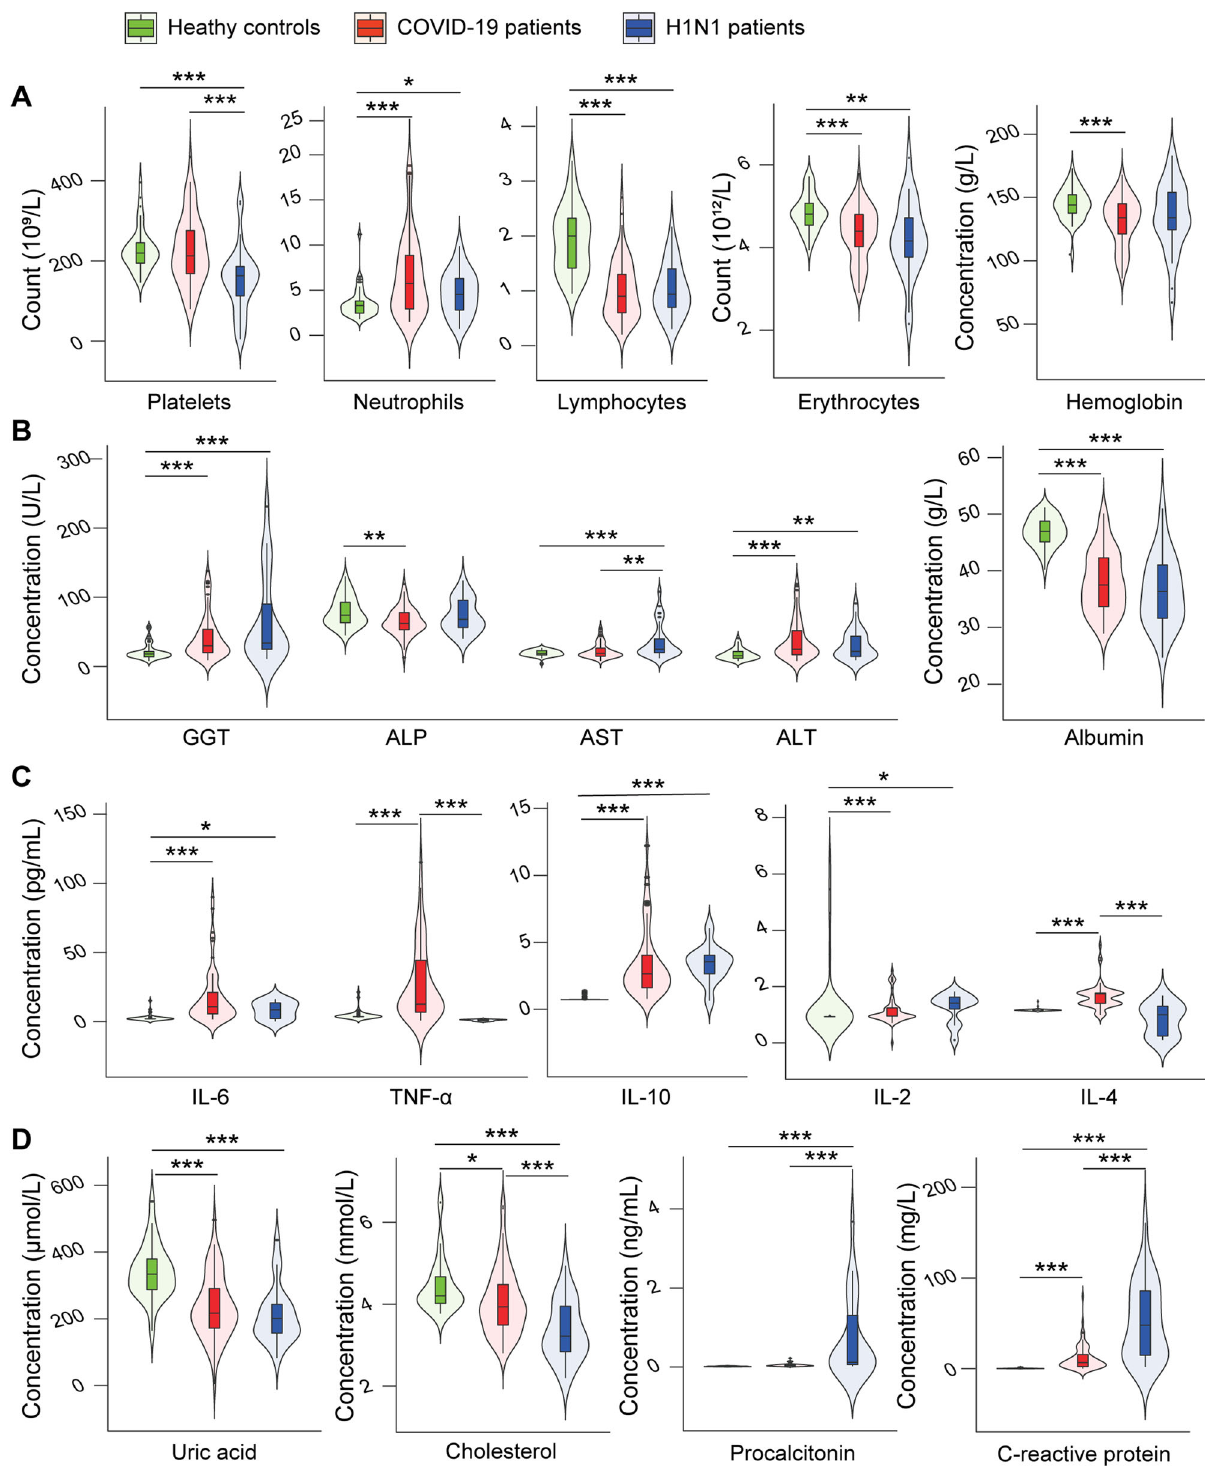
Fig. 1 Alterations in in fl ammatory, hepatic, metabolic and infectious biomarkers in blood from patients with COVID-19 or H1N1 infections compared with HCs. Signi fi cantly altered ( A ) blood haemocytes and haemoglobin, B liver function indicators, C in fl ammatory cytokines, and ( D ) metabolic and infectious biomarkers in the blood of patients with COVID-19 ( n = 67) or H1N1 ( n = 35) infections compared with HCs ( n = 48). * P < 0.05; ** P < 0.01; and *** P < Associations between faecal mycobiota and the bacterial Agathobacter , Dorea and Roseburia ; with Ruminococcaceae and microbiota . In COVID-19 patients, the phylum Ascomycota its genera Butyricicoccus and Faecalibacterium ; and with Egger- thella and Veillonella (Fig. 5A). In contrast, the phylum Mucor- and its members Aspergillus niger and Aspergillus rugulosus omycota was positively correlated with Peptostreptococcaceae , were negatively correlated with Lachnospiraceae and its genera